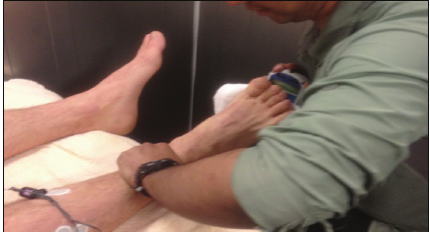
Figure 3: Measuring plantar flexion force using the hand held